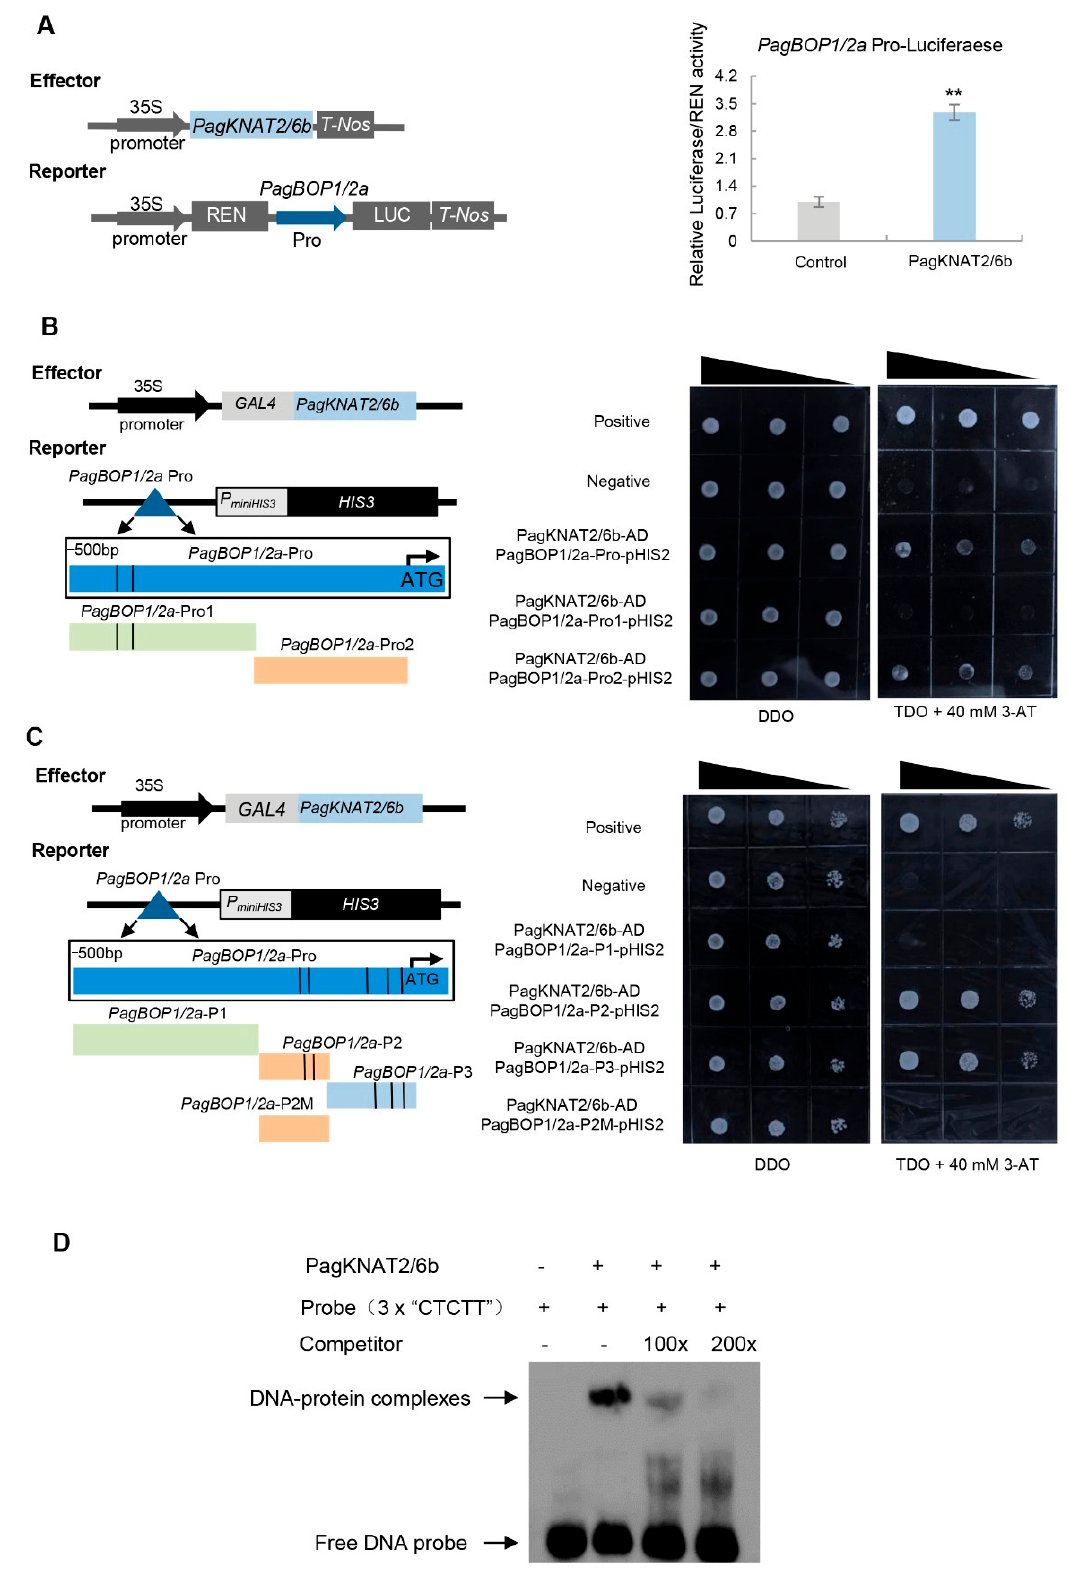
Figure 5. The regulation of PagBOP1/2a by PagKNAT2/6b through the “CTCTT” element. ( A ) Tran- sient transcriptional activity assay to examine the regulation of PagBOP1/2a by PagKNAT2/6b. The 2-kb promoter region of PagBOP1/2a was used to construct the reporter vector. Asterisks represent